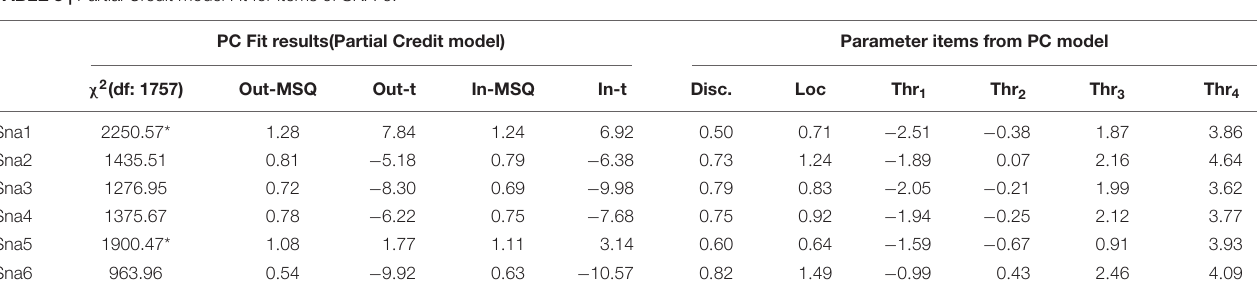
TABLE 3 | Partial Credit model Fit for ítems of